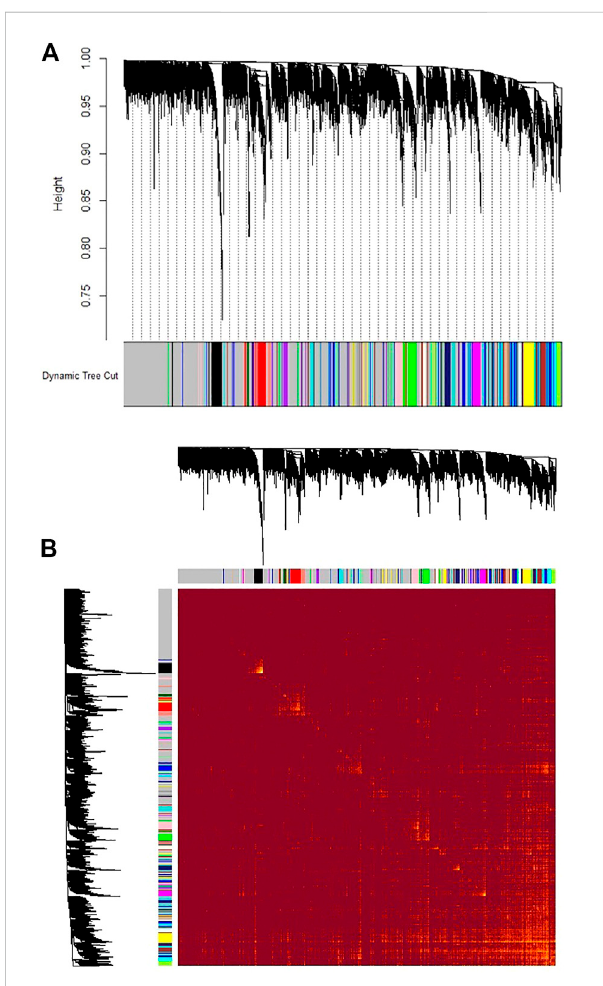
FIGURE 3 Gene co-expression modules which grouped the reliably expressed genes (with read count > 10 in more than 10% of the samples) into 22 modules. (A) The height ( y -axis) indicates the co- expression distance and the x -axis corresponds to genes. Colors represent the 22 modules. The gray module represent genes that assignedtoneitherofthe22modules. (B) Heatmapplotoftopological overlap in the gene network. Each row and column corresponds to a gene, light color denotes low topological overlap, and progressively darker red denotes higher topological overlap. Darker squares along the diagonal correspond to modules. The gene dendrogram and module assignment are shown along the left and